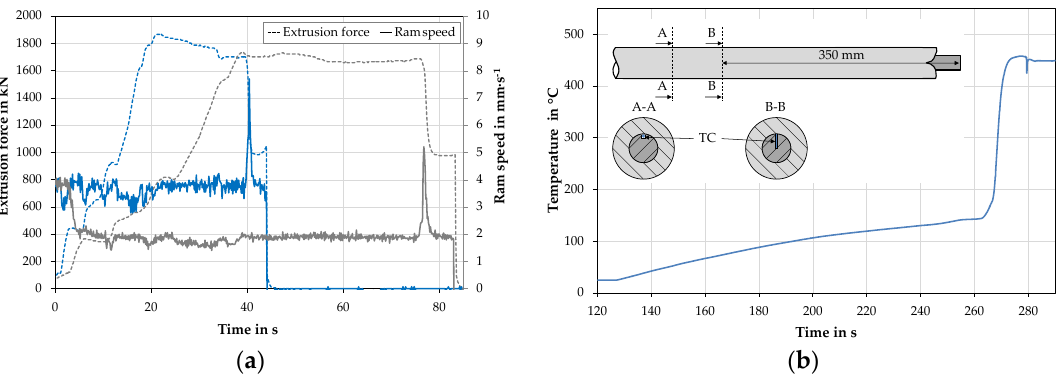
Figure 4. ( a ) Extrusion force-time diagrams and ram speed-time diagrams obtained experimentally at an average ram speed of 2 mm·s −1 (grey) and 4 mm·s −1 (blue); ( b ) Experimentally measured temperature of the steel rod for a ram speed of 2 mm·s −1 with schematically displayed position of the thermocouple (TC).